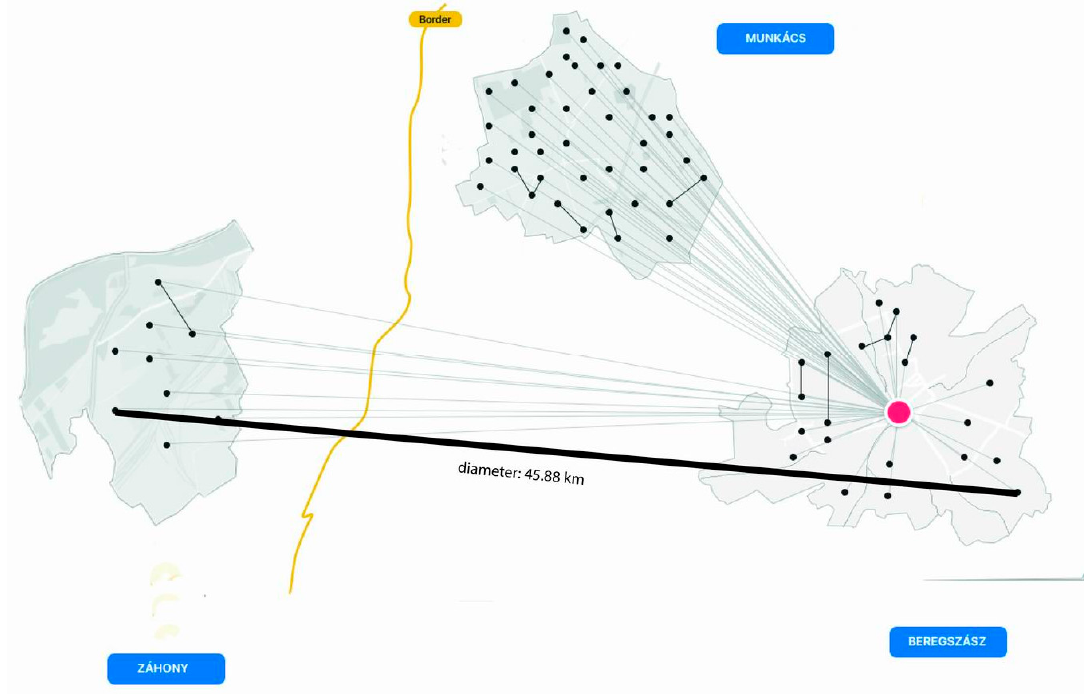
Figure 4. Diameter of NZBM. Source: Author.